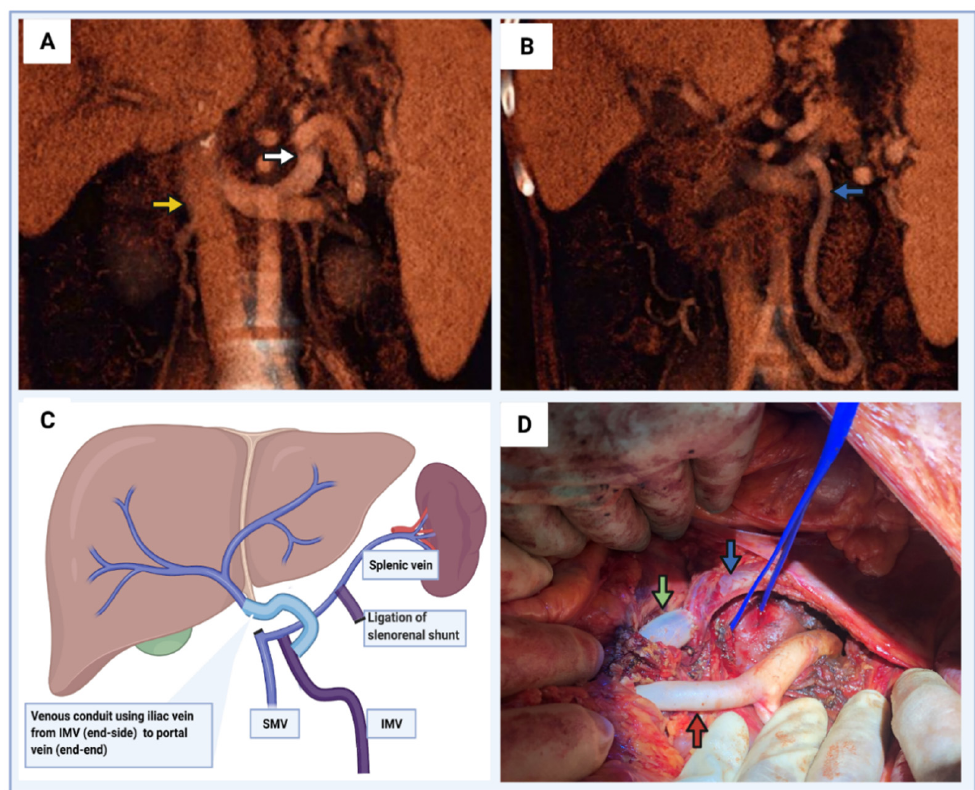
Figure 5. Portal vein thrombosis with large spontaneous portosystemic shunts. ( A ) Coronal CT image demonstrating large splenorenal shunt (white arrow). Yellow arrow demonstrates the infrahepatic IVC at the level of left renal vein insertion. ( B ) Prominent inferior mesenteric vein due to obstruction of intestinal venous drainage via the superior mesenteric vein. ( C ) Schematic diagram demonstrating vascular reconstruction to restore portal venous inflow. The large inferior mesenteric vein was used for the proximal anastomosis of a vein allograft. The splenorenal shunt should be ligated to allow preferential flow directed to liver and reduce competitive flow via the shunt. ( D ) Intraoperative image of vascular reconstruction demonstrated in panel ( C ). Proximal end of vein allograft (green arrow) anastomosed to the inferior mesenteric vein (blue arrow). Proximal end of the splenorenal shunt identified with a blue vessel loop. Infrarenal aortic conduit also identified (red arrow).